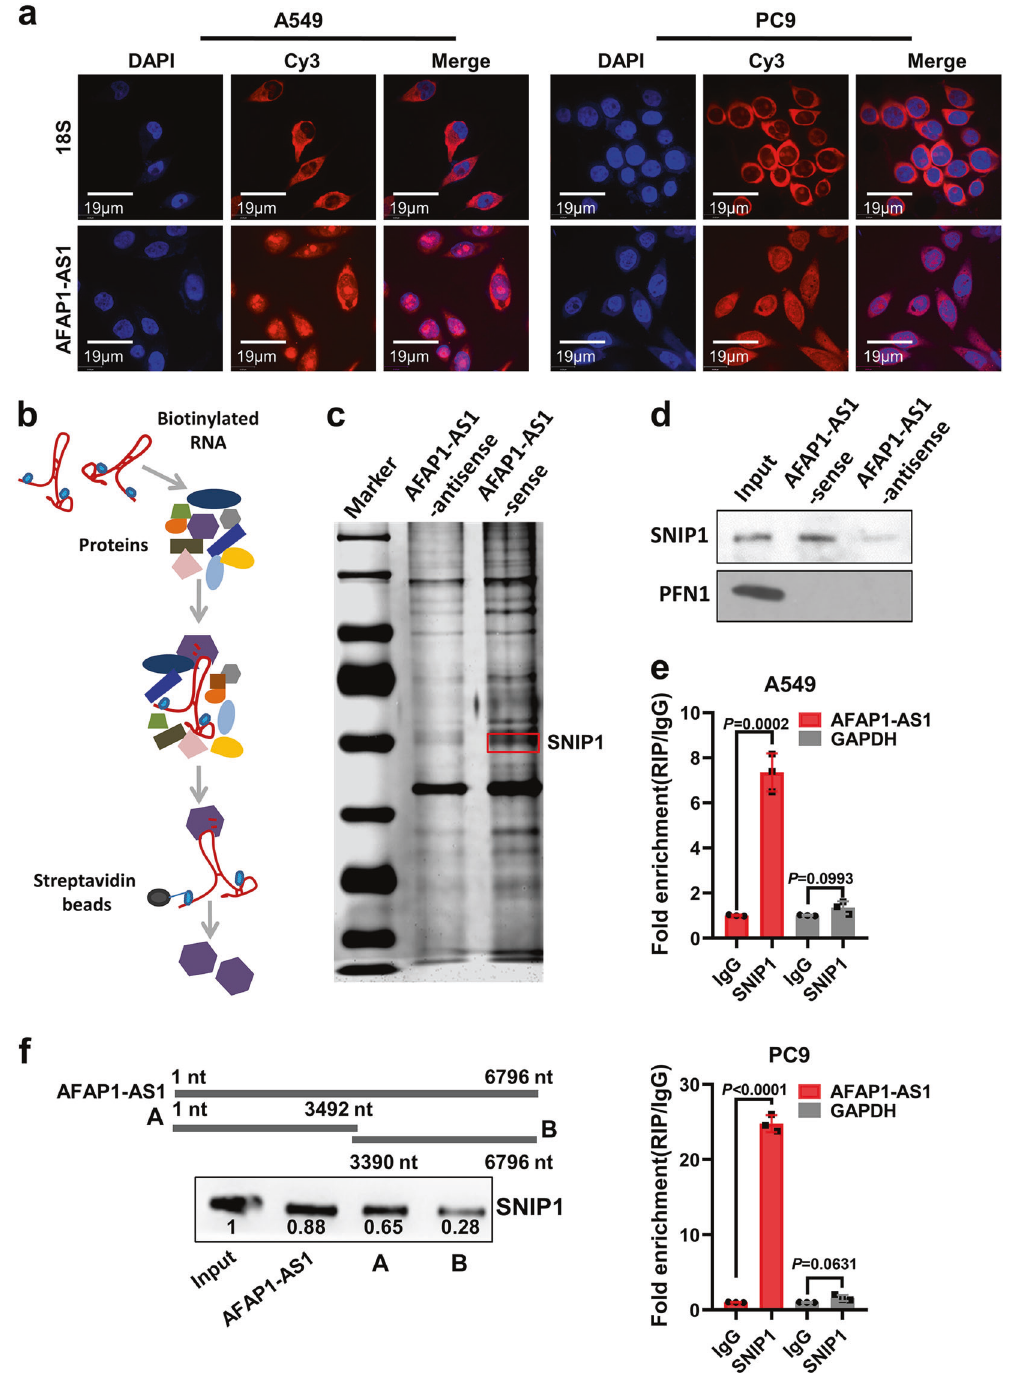
Fig. 3 AFAP1-AS1 physically interacts with SNIP1 protein. a RNA FISH experiment was done to examine the localization and AFAP1-AS1 expression in A549 and PC9 cells. AFAP1-AS1 was distributed in both cytoplasm and nucleus. The RNA 18 S, localized in the cytoplasm, was used as a positive control. DAPI-stained nucleus: blue; Cy3 at the 5 ′ end of the probe (AFAP1-AS1 or 18 S): red; the merged image represents the overlap of DAPI and AFAP1-AS1 (Scale bar: 19 μ m). b Schematic diagram of RNA pull down experiment performed to identify proteins of associated with AFAP1-AS1. Biotinylated sensor antisense or sense AFAP1-AS1 RNA was incubated with lysates of A549 cells targeted with streptavidin beads. Interacting proteins were resolved, visualized by silver staining, and identi fi ed by LC-MS/MS. c The result of silver staining of RNA pull down proteins. The red square indicates the approximate position of SNIP1. d Western blotting analysis shows that AFAP1-AS1 speci fi cally interacts with SNIP1 protein but not PFN1 protein (a negative control). e RIP of AFAP1-AS1 in A549 and PC9 cells using anti-SNIP1 or IgG antibodies. The fold enrichment of AFAP1-AS1 is shown relative to that of the matched control IgG. RIP, RNA immunoprecipitation. f The deletion-mapping assay showed that the A fragment (1 – 3492 nt) of AFAP1-AS1 interacted with SNIP1 protein. Data are presented as the means ± SD